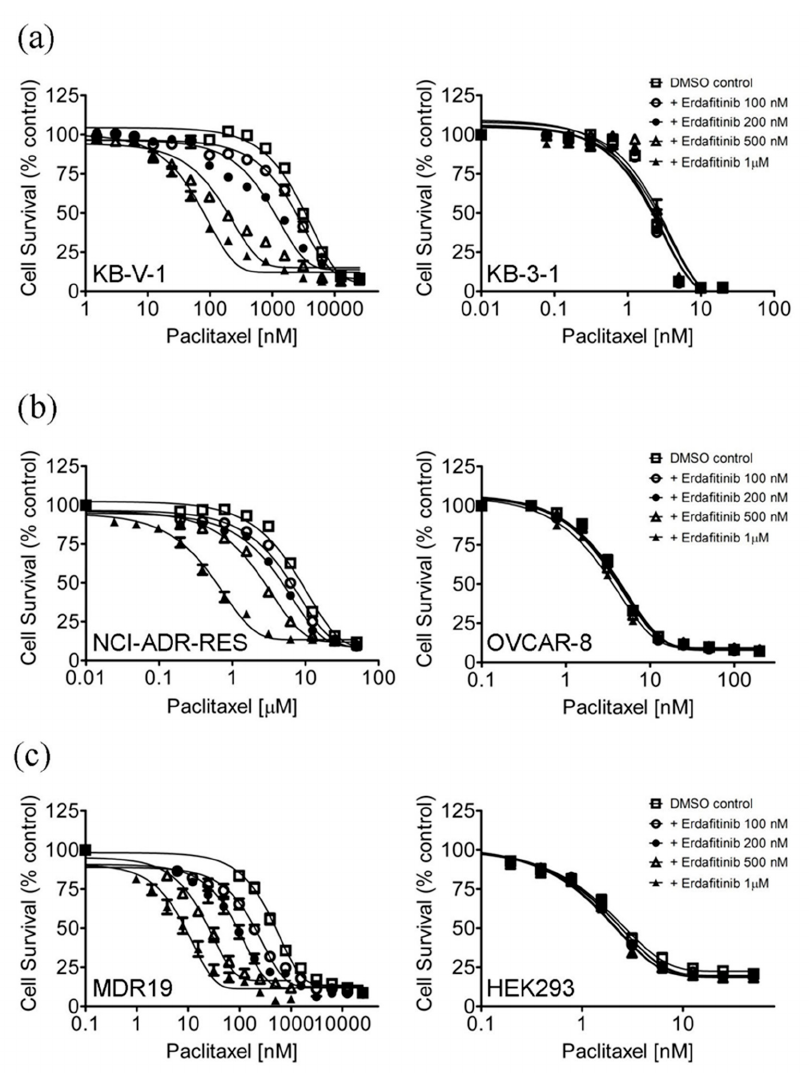
Figure 1. Erdafitinib sensitizes ABCB1-overexpressing multidrug-resistant cells to the ABCB1 substrate drug paclitaxel. The effect of erdafitinib on ABCB1-mediated paclitaxel resistance was examined in ( a ) ABCB1-overexpressing multidrug-resistant KB-V-1 human epidermal cancer cells (left panel) and the corresponding drug-sensitive parental KB-3-1 cancer cells (right panel), ( b ) ABCB1-overexpressing NCI-ADR-RES human ovarian cancer cells (left panel) and the corresponding drug-sensitive parental OVCAR-8 cancer cells (right panel) as well as ( c ) HEK293 cells transfected with human ABCB1 (MDR1, left panel) and parental HEK293 cells (right panel). Cells were treated with increasing concentrations of paclitaxel, a well-known substrate of ABCB1, in the presence of DMSO (open squares) or erdafitinib at 100 nM (open circles), 200 nM (filled circles), 500 nM (open triangles), or at 1.0 μ M (filled triangles). Points, mean values from at least three independent experiments; bars; S.E.M.